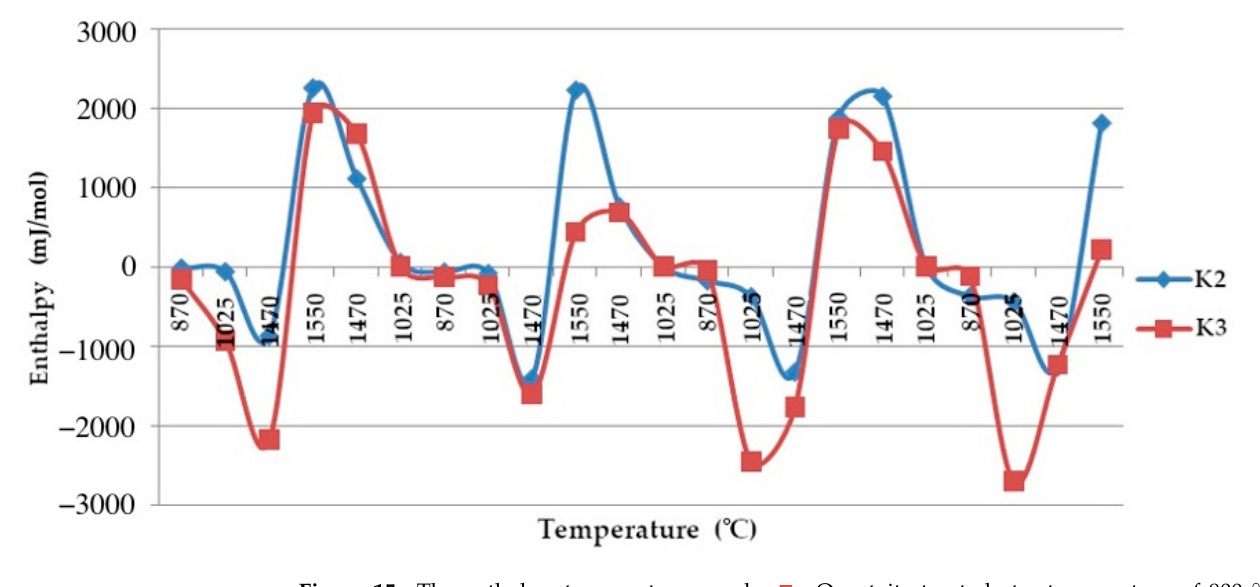
Based on these data, a graph of the changes in the enthalpy of quartzites is shown in Figure 15.